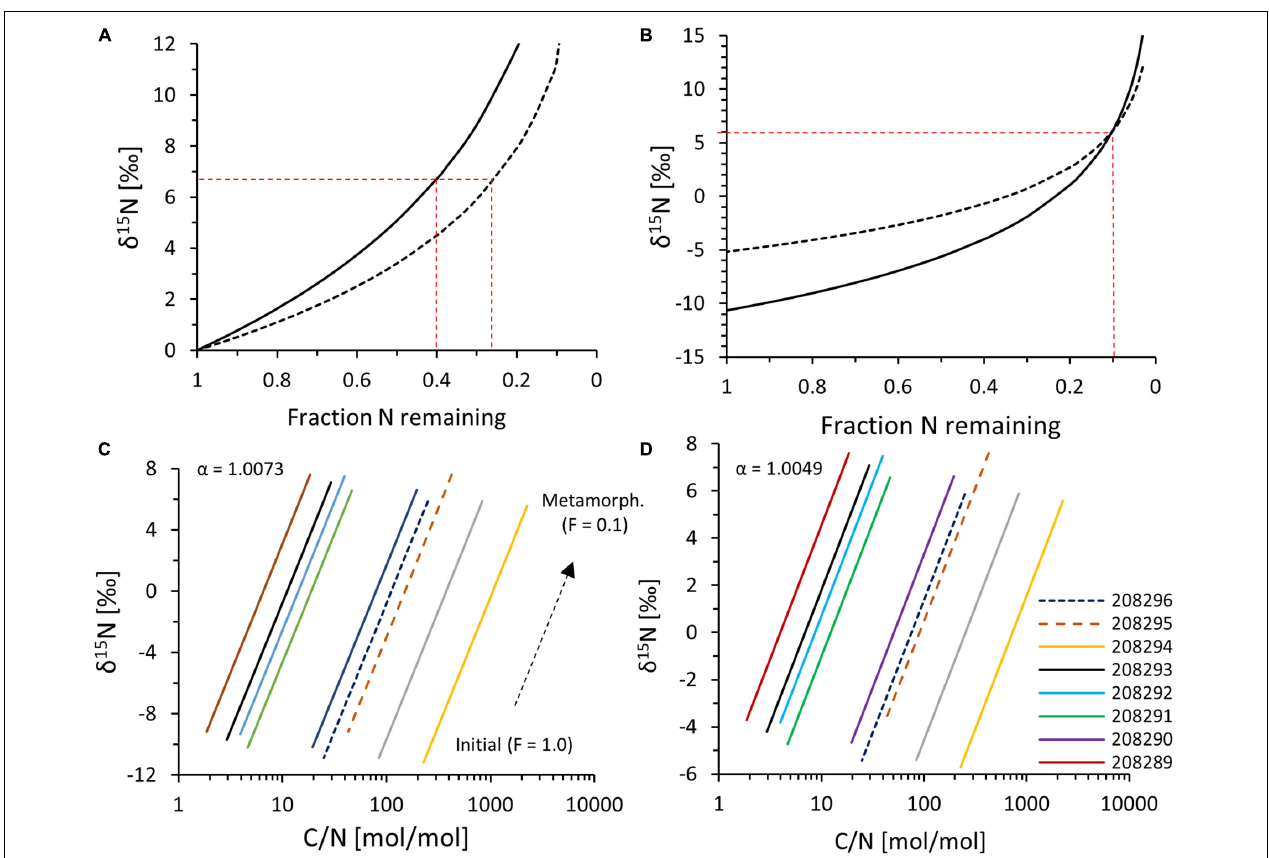
and fractionation factors ( α ) of either 1.0049 (dashed line) or 1.0073 (solid line). Red dashed FIGURE 6 | (A) Rayleigh fractionation model with fixed δ 15 N initial = 0 lines = F values corresponding to δ 15 N = +6.7 , which is the average authigenic N component. (B) Rayleigh fractionation model, adjusting δ 15 N initial such that (cid:104) δ 15 N metamorphic = +6.7 at F = 0.1. (C) Evolution of authigenic δ 15 N and C/N ratios at α = 1.0073. (D) Evolution of authigenic δ 15 N and C/N ratios at α = 1.0049. (cid:104) (cid:104) α = 1.0049 for N-loss as N 2 (for the reaction N 2 –NH 3